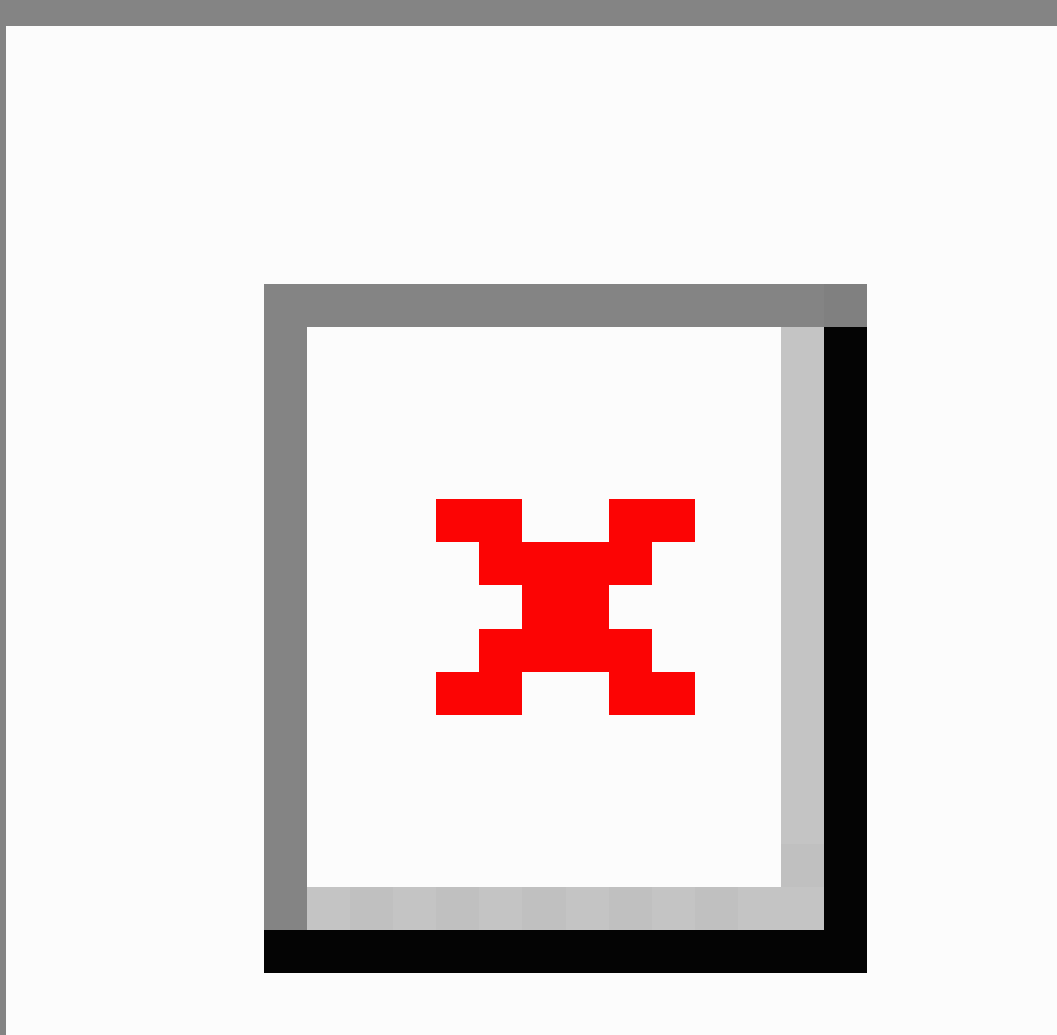
Figure 1. The contrast sensitivity test stimuli letters. A total of 16 rows of letter triplets were presented to the respondents, with row 1 letter triplet being of highest contrast and row 16 letter triplet being of lowest contrast. Represented from top to bottom are row 1, row 2, row 3, row 9, row 10 and row 11 of the letter